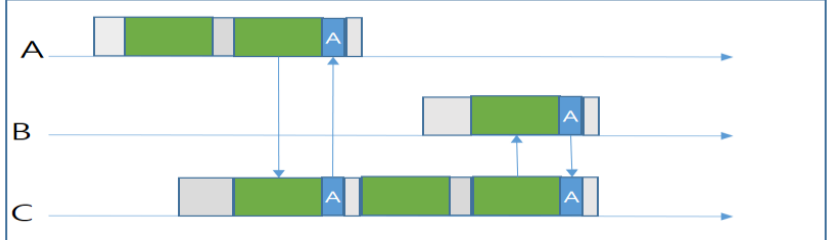
Figure 14. Packet transmission in ORW [11].